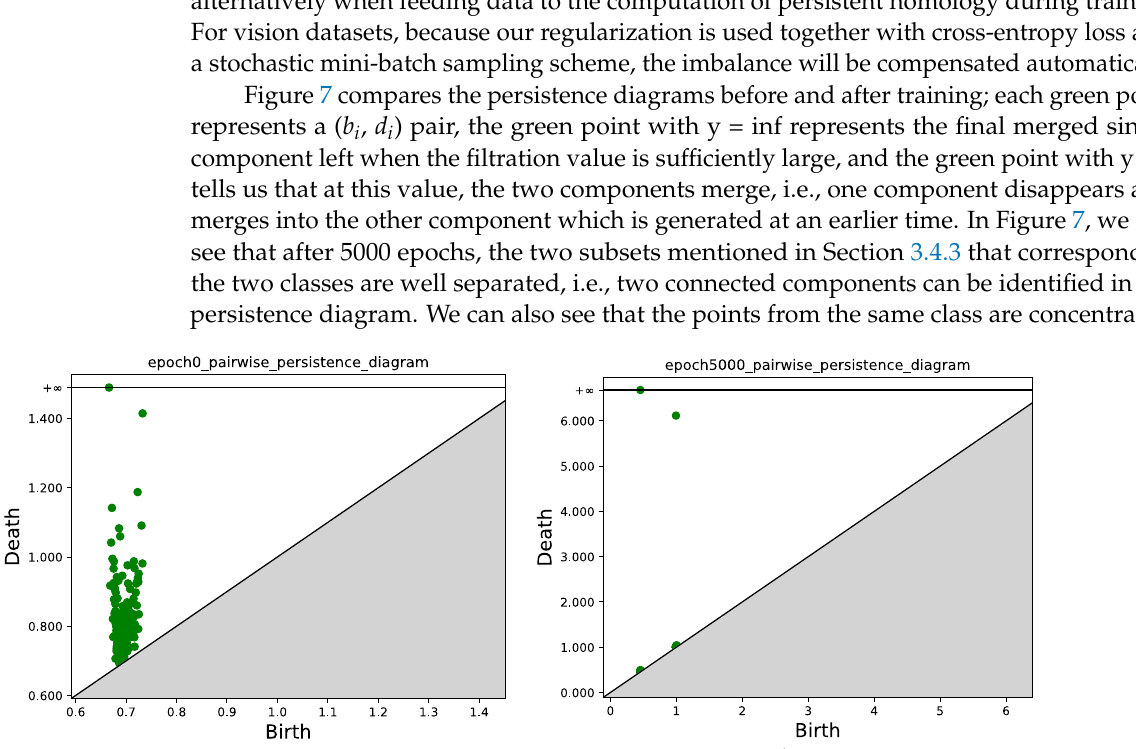
( b ) Figure 8. ( a ) The original points are sampled from a Gaussian mixture with four components, and each class corresponds to two components; the purple points are sampled from class 1, and the red